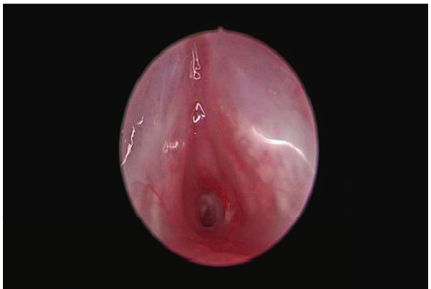
Figure 6: Grade III subglottic stenosis.